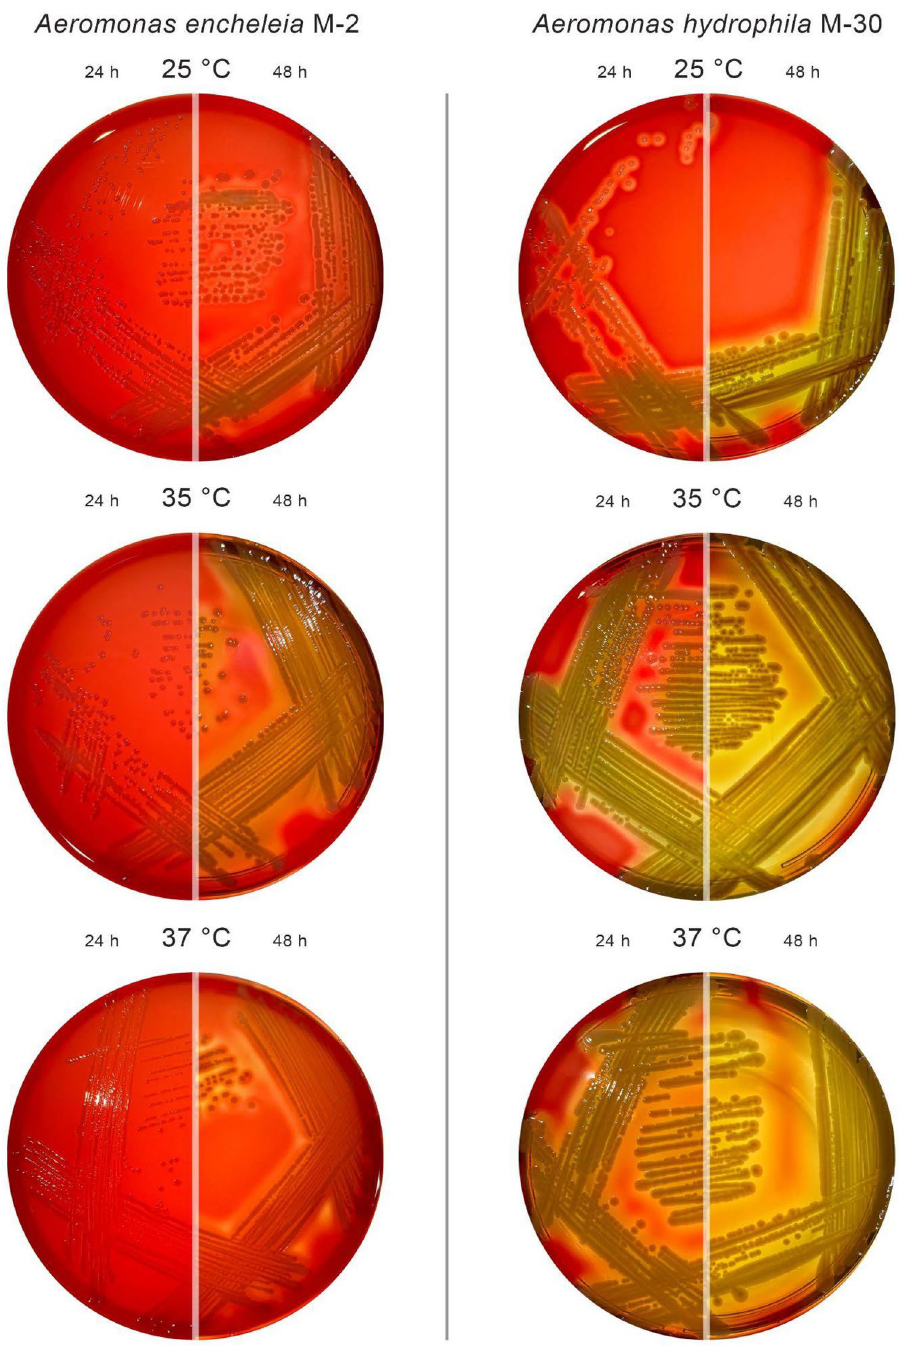
Figure 3. Hemolytic activities of M-2 and M-30 Aeromonas strains on 5% human O-blood agar